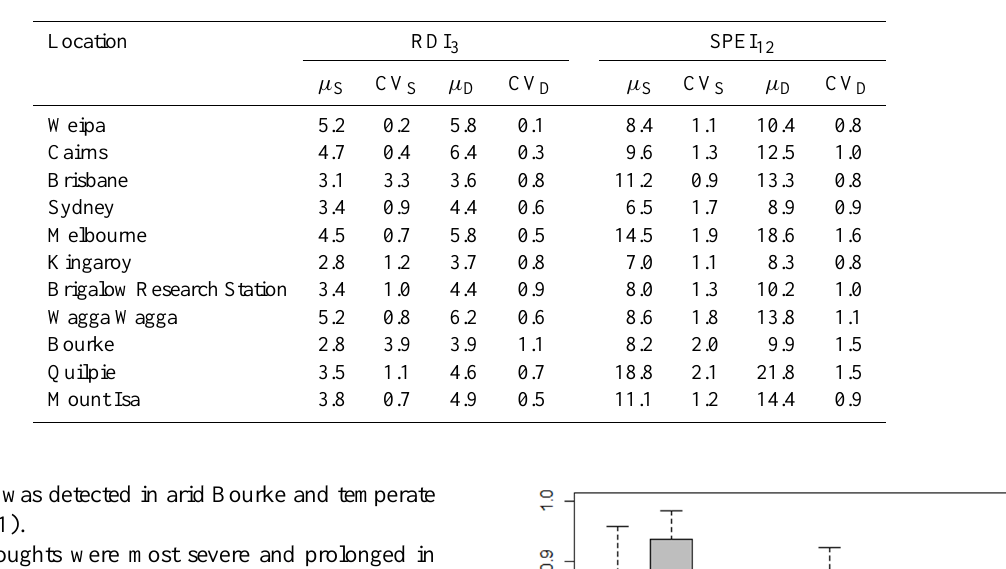
Table 2. Mean severity µ S and duration µ D of selected locations across eastern Australia, and corresponding coefficient of variation CV S and CV D for short-term (RDI 3 ) and long-term (SPEI 12 ) droughts.